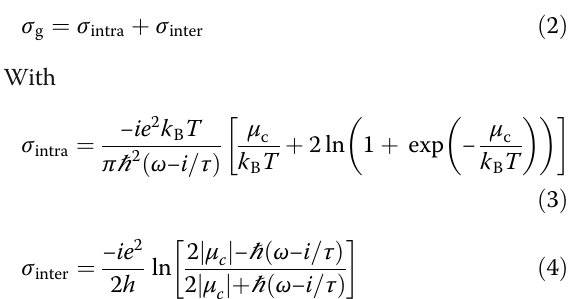
μ τ = 1 c1 = 0.3 eV; and